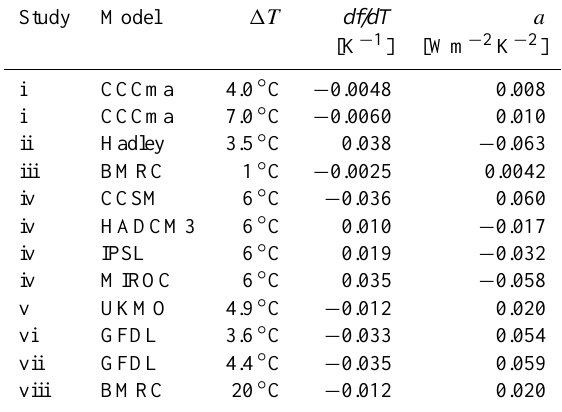
Table 1. Modelled feedback nonlinearities: (i) Boer and Yu (2003), (ii) Senior and Mitchell (2000), (iii) Colman et al. (1997), (iv) Crucifix (2006), (v) Hewitt and Mitchell (1997), (vi) Broccoli and Manabe (1987), (vii) Wetherald and Manabe (1975), (viii) Colman and McAveny (2009). These studies use various ways of estimating climate sensitivity and thus feedbacks as a function of mean